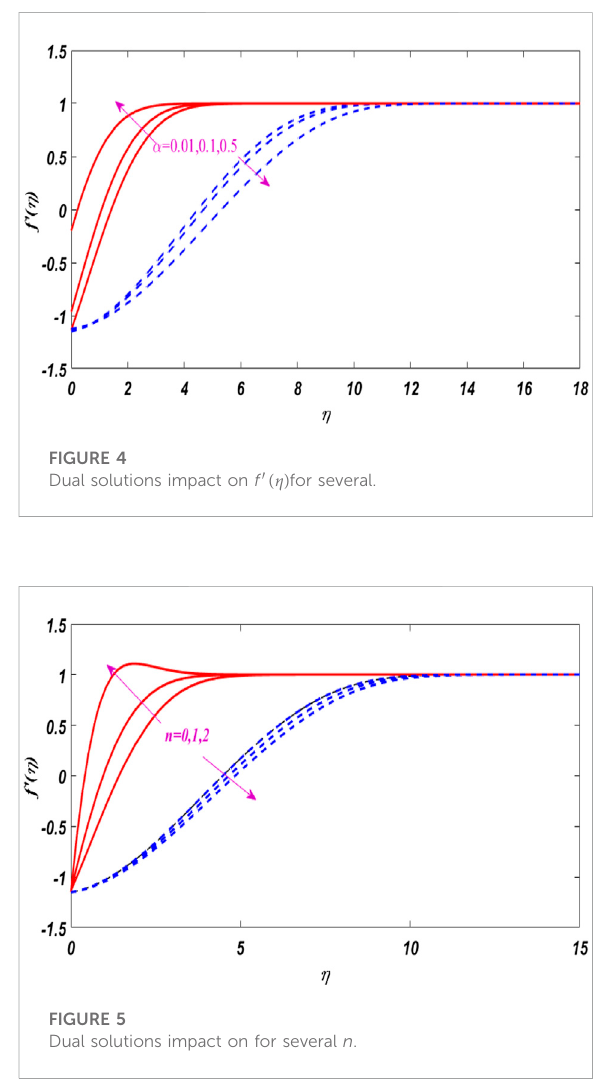
FIGURE 5 Dual solutions impact on for several n .